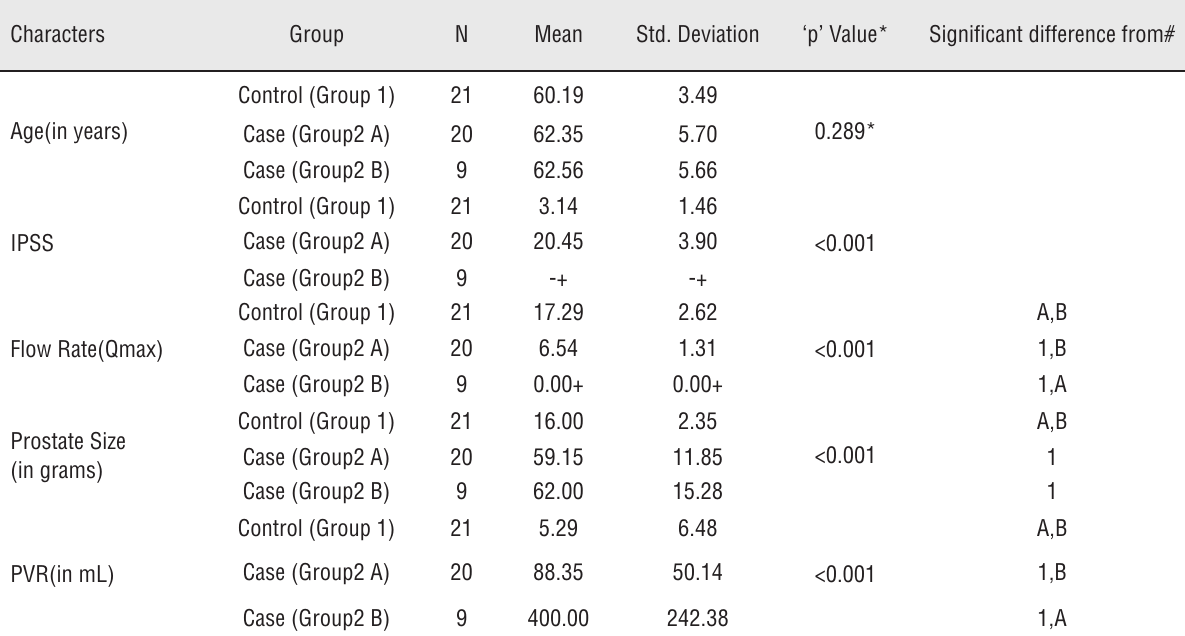
Table 1 - Preoperative (Baseline) comparison between